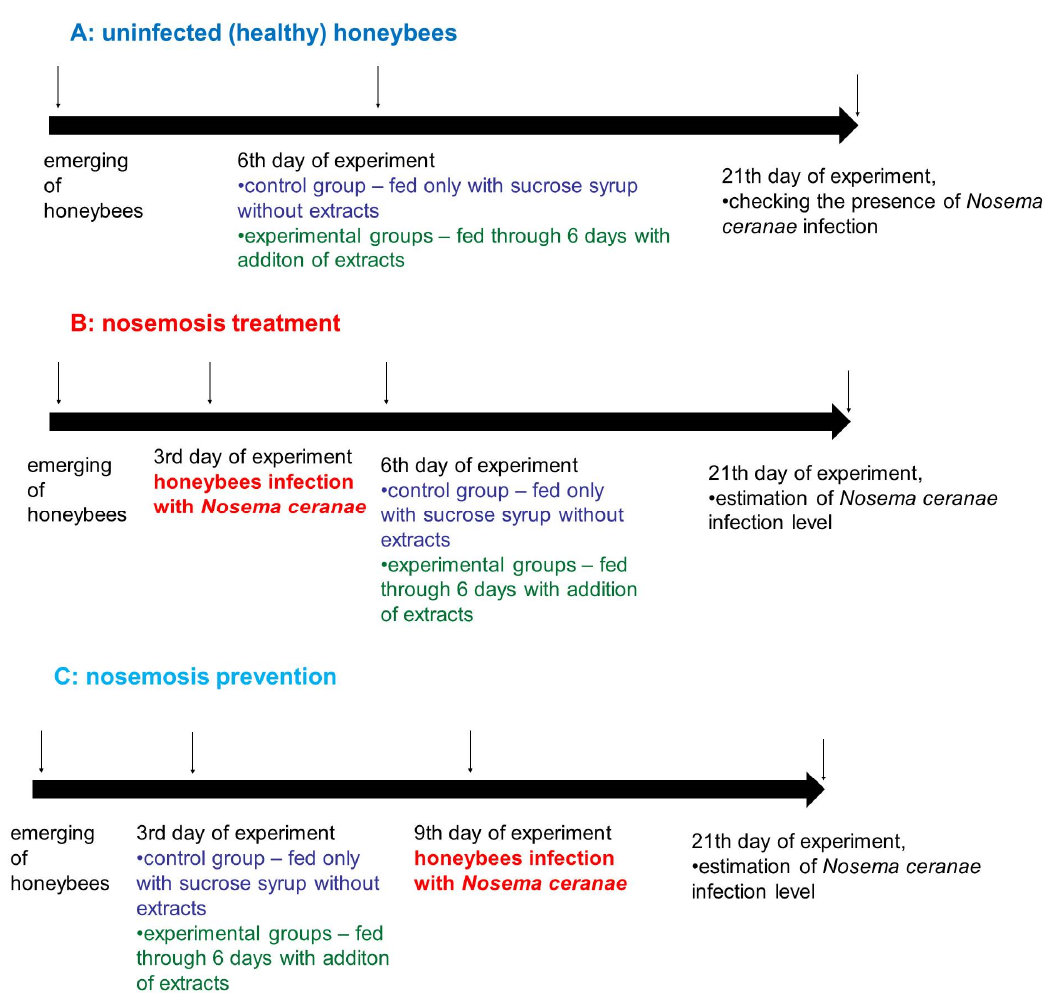
Figure 6. The scheme of administered experiments analysing the effect of extracts on honeybees which were uninfected and infected with Nosema ceranae .